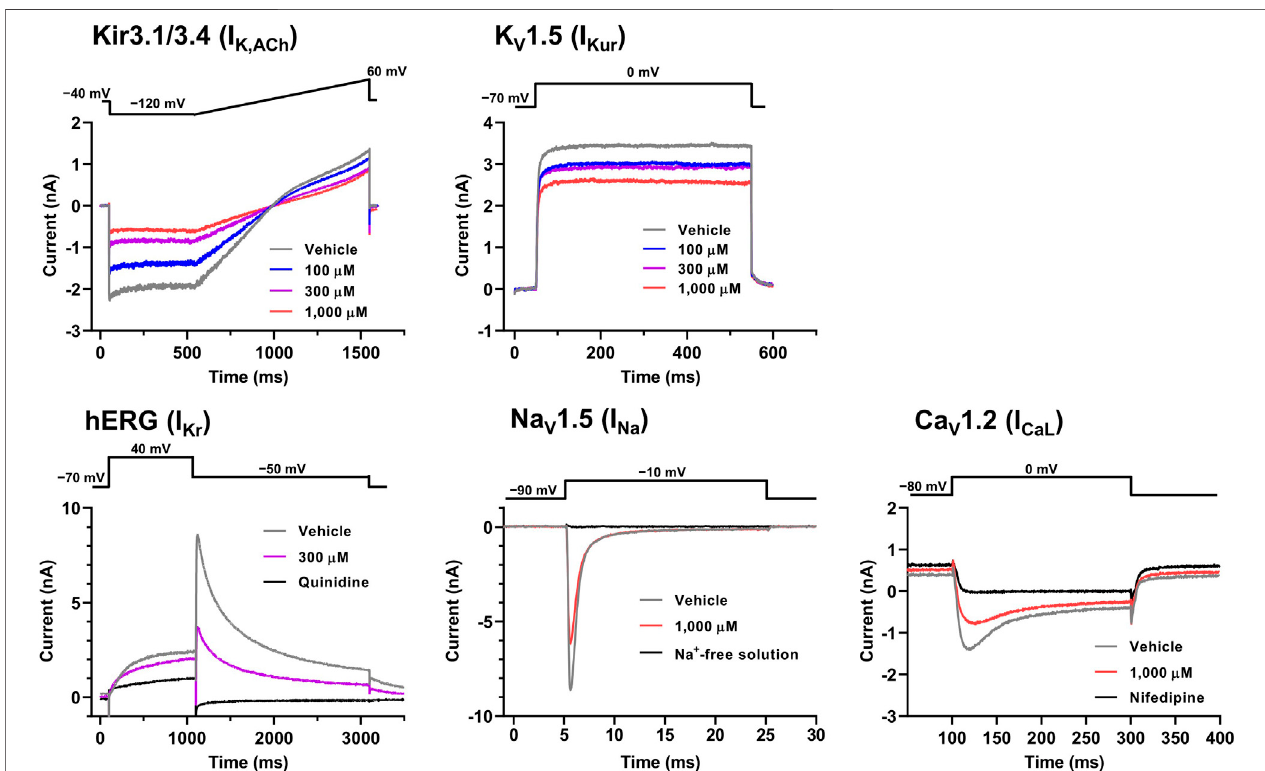
FIGURE6| Voltageprotocols (upper) andrepresentativecurrentwaveforms (lower) showingtheinhibitoryactionsofoseltamivir phosphate onKir3.1/3.4, K V 1.5, hERG, Na V 1.5 and Ca V 1.2-derived currents. The current waveforms of Kir3.1/3.4 and K V 1.5-derived currents were recorded with vehicle and 100 – 1,000 μ M of oseltamivir, whereas those of hERG, Na V 1.5, Ca V 1.2-derived currents were done with vehicle, 300 or 1,000 μ M oseltamivir, and relevant ion channel blockers (100 μ M quinidine or 30 μ M nifedipine) or Na + -free solution.